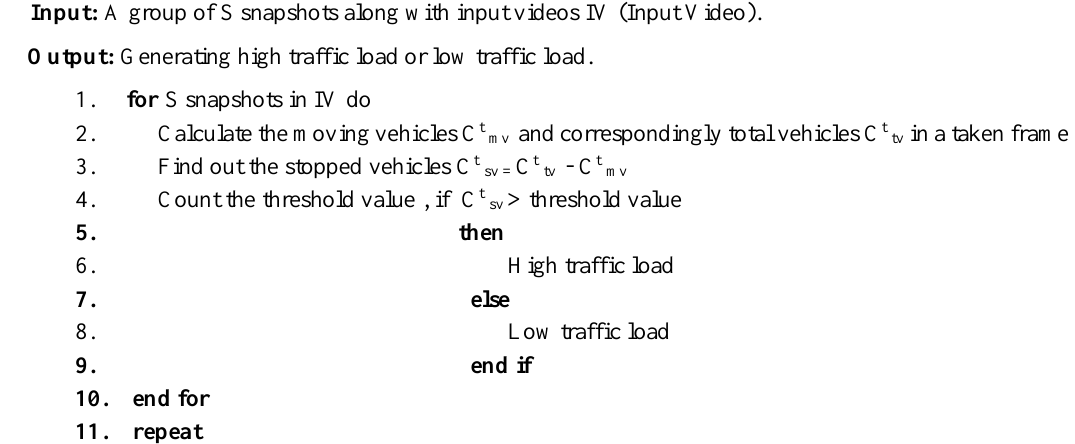
Algorithm 1: For semantically measured traffic